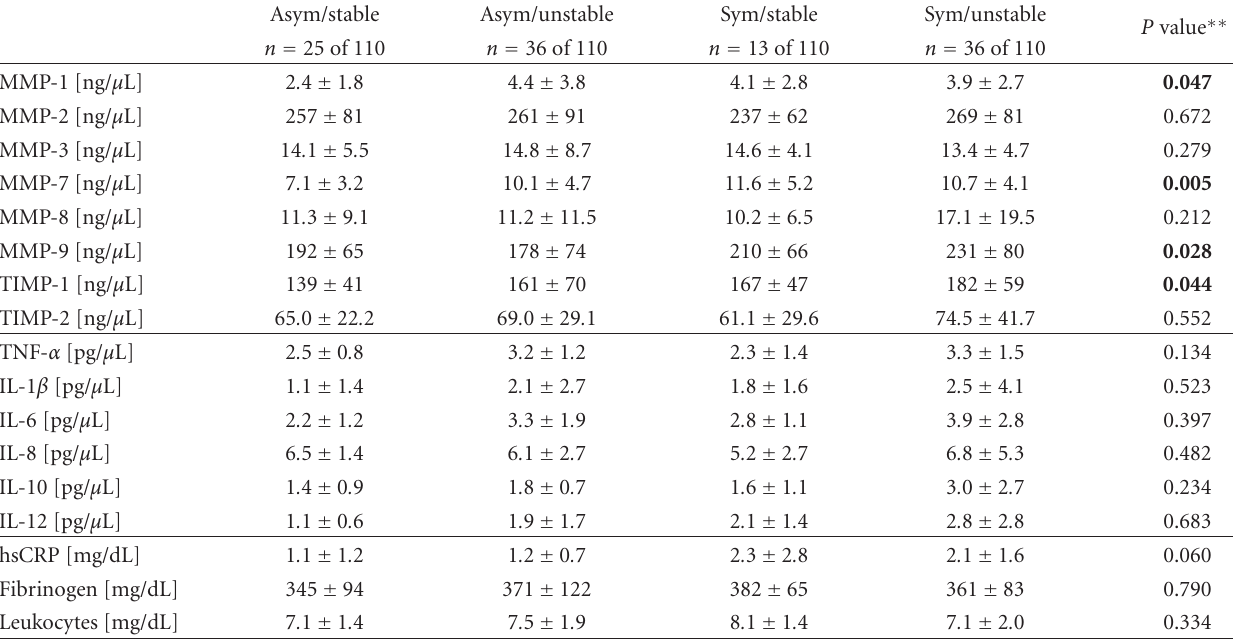
Table 2: Levels of various clinical factors in blood serum of study